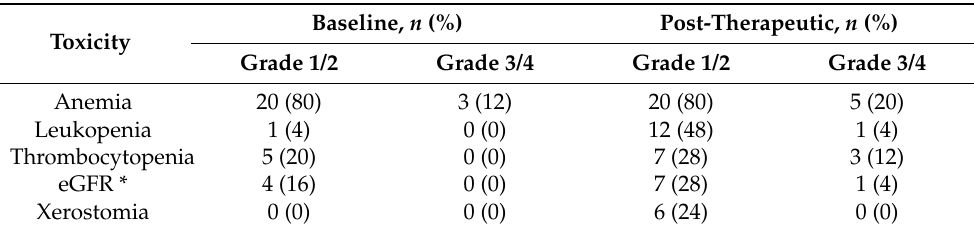
Table 2. Hematologic, renal, and salivary gland toxicity grades based on CTCAE v5.0. at baseline and after at least one cycle of LuPSMA-RLT or during